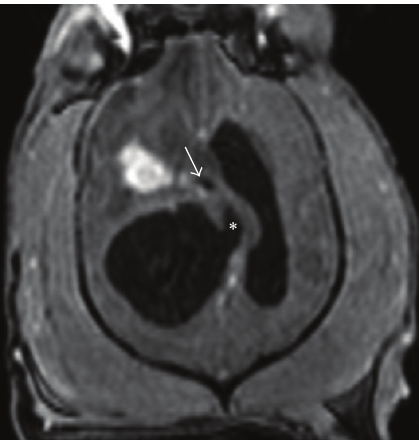
Figure 2: Preoperative postcontrast T1-weighted dorsal MR image of the head. There is subfalcine herniation of the right lateral ventricle (asterisk) with subsequent suspected isolation of the lateral ventricle from the third ventricle